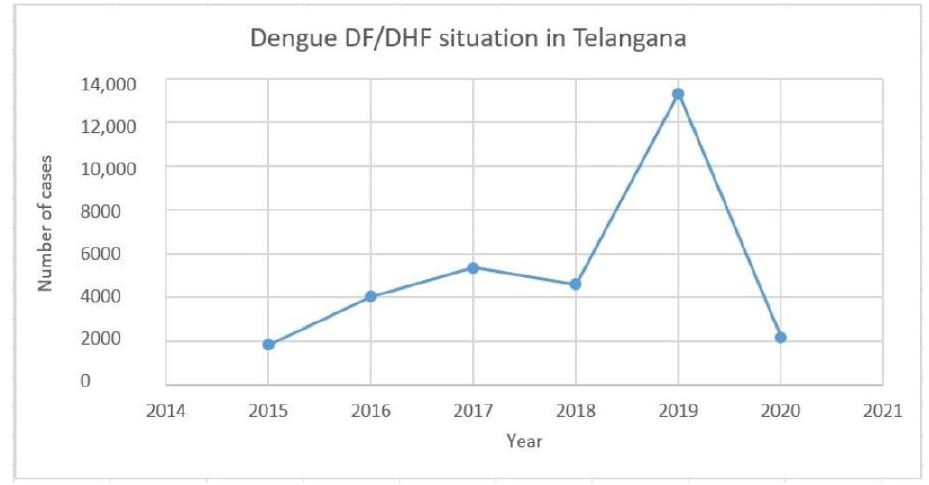
Figure 3. Epidemiological trend of dengue cases in the state of Telangana from 2015 to 2020 based on data available from the National Vector Borne Disease Control Program (NVBDCP).